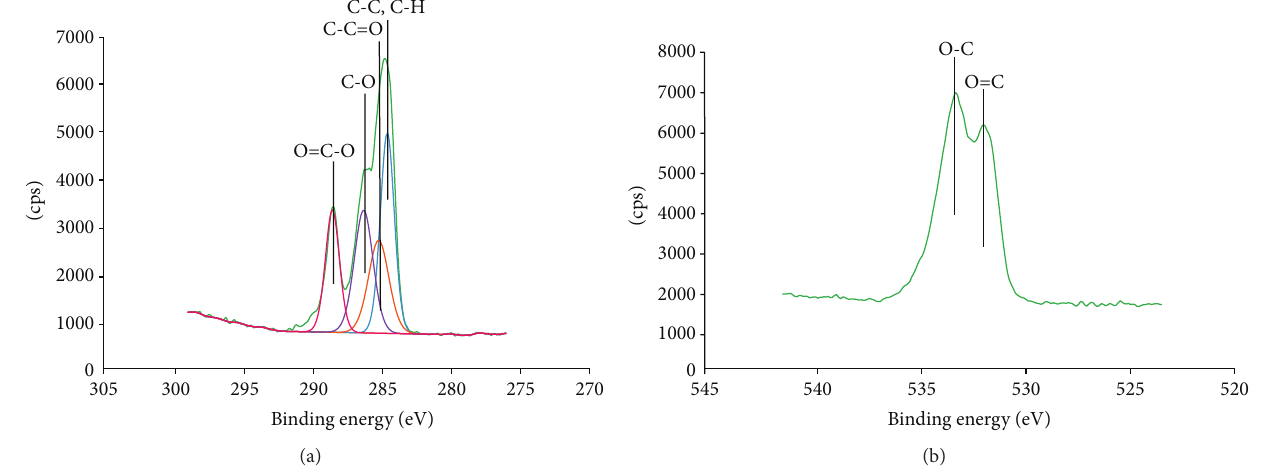
Figure 4: XPS analysis of PMMA QCM sensor. Curve-fitted C1s XPS spectra (a) and core-level XPS spectrum of O1s (b) for a PMMA film.